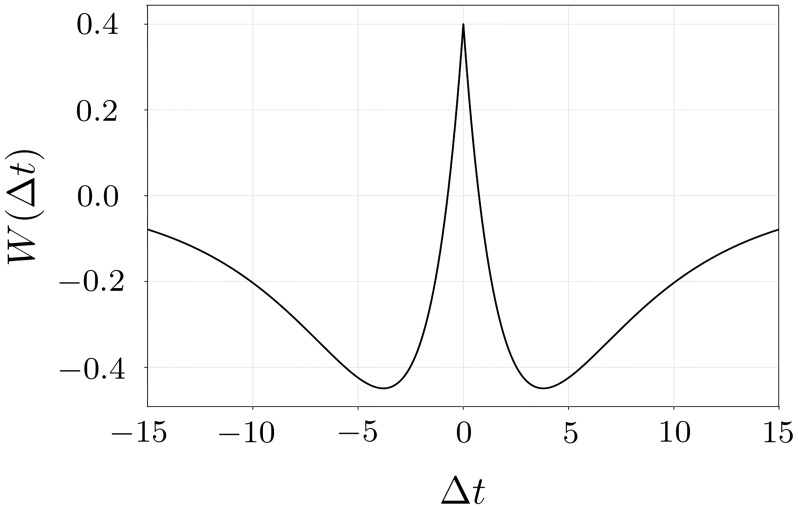
Plasticity function W(Δtij) for τp = 2, τd = 5, cp = 2, cd = 1.6.